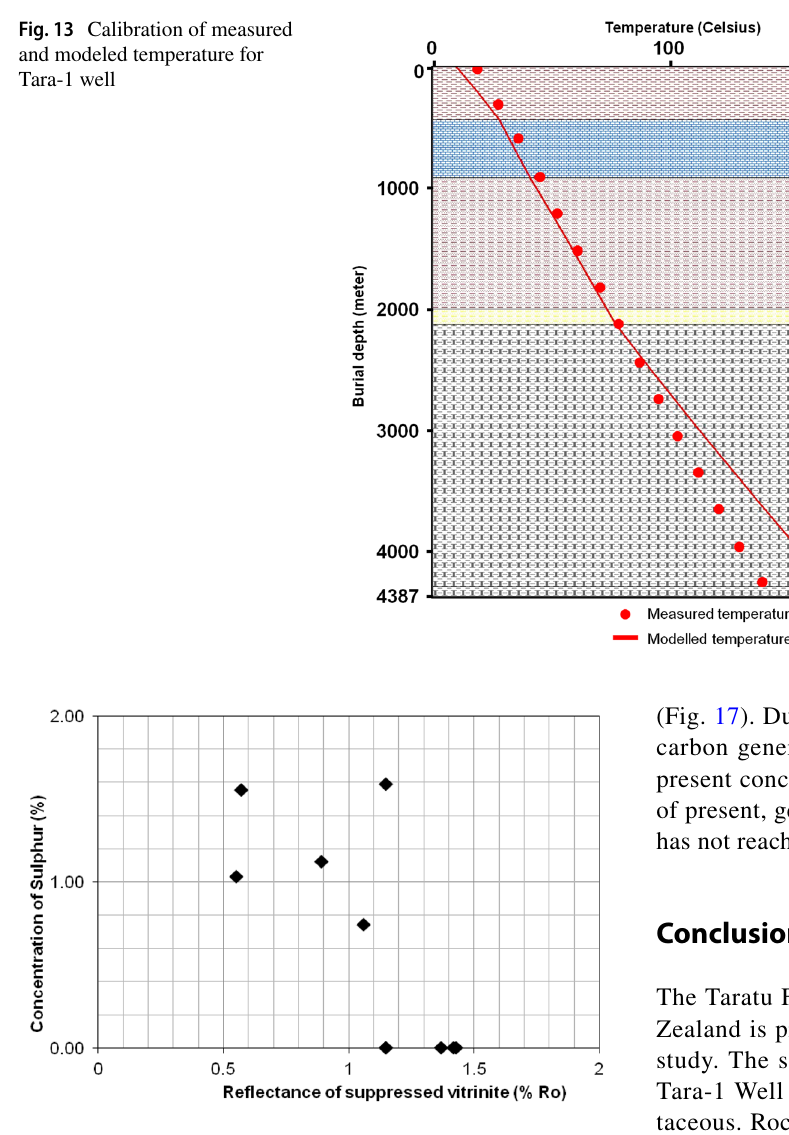
Fig. 14 Correlation between sulfur and % R between both